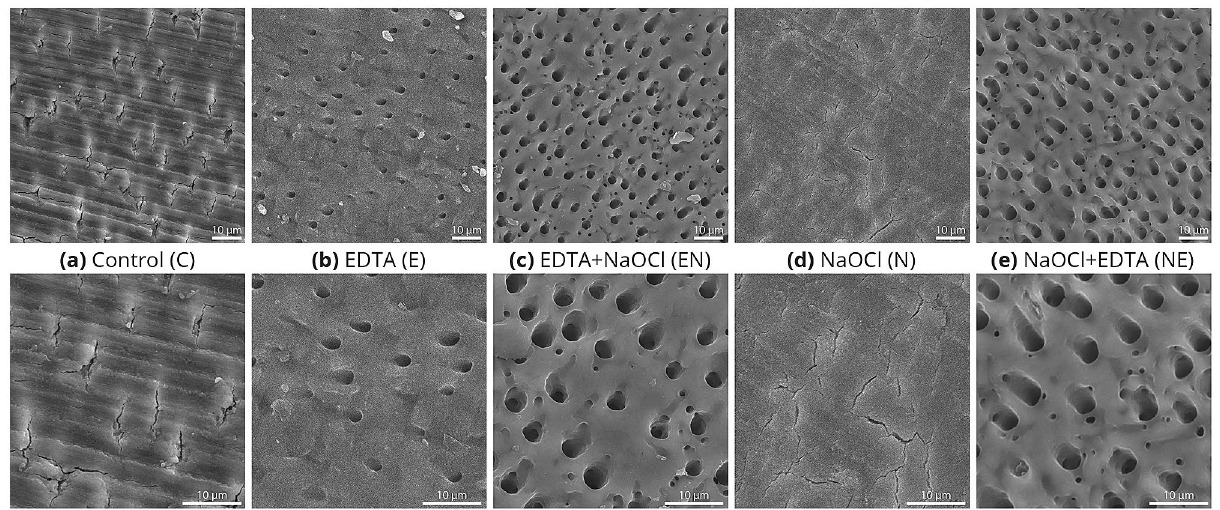
Figure 4. SEM images of the dentin surfaces following the different irrigation protocols. × 1000 (top row) and × 2000 magnifications (bottom row). ( a ) Control; ( b ) EDTA 17%; ( c ) EDTA 17% followed by NaOCl 5.25%; ( d ) NaOCl 5.25%; ( e ) NaOCl 5.25% followed by EDTA 17%. Scale bar: 10